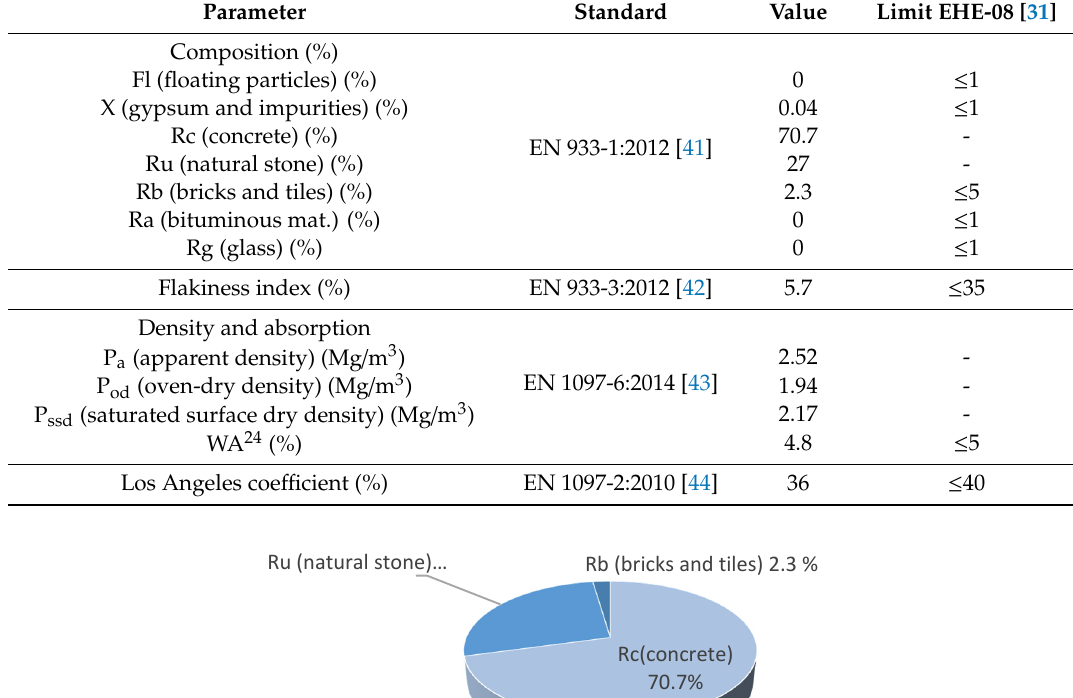
Table 3. Composition and physical and mechanical characterization of the recycled aggregates.